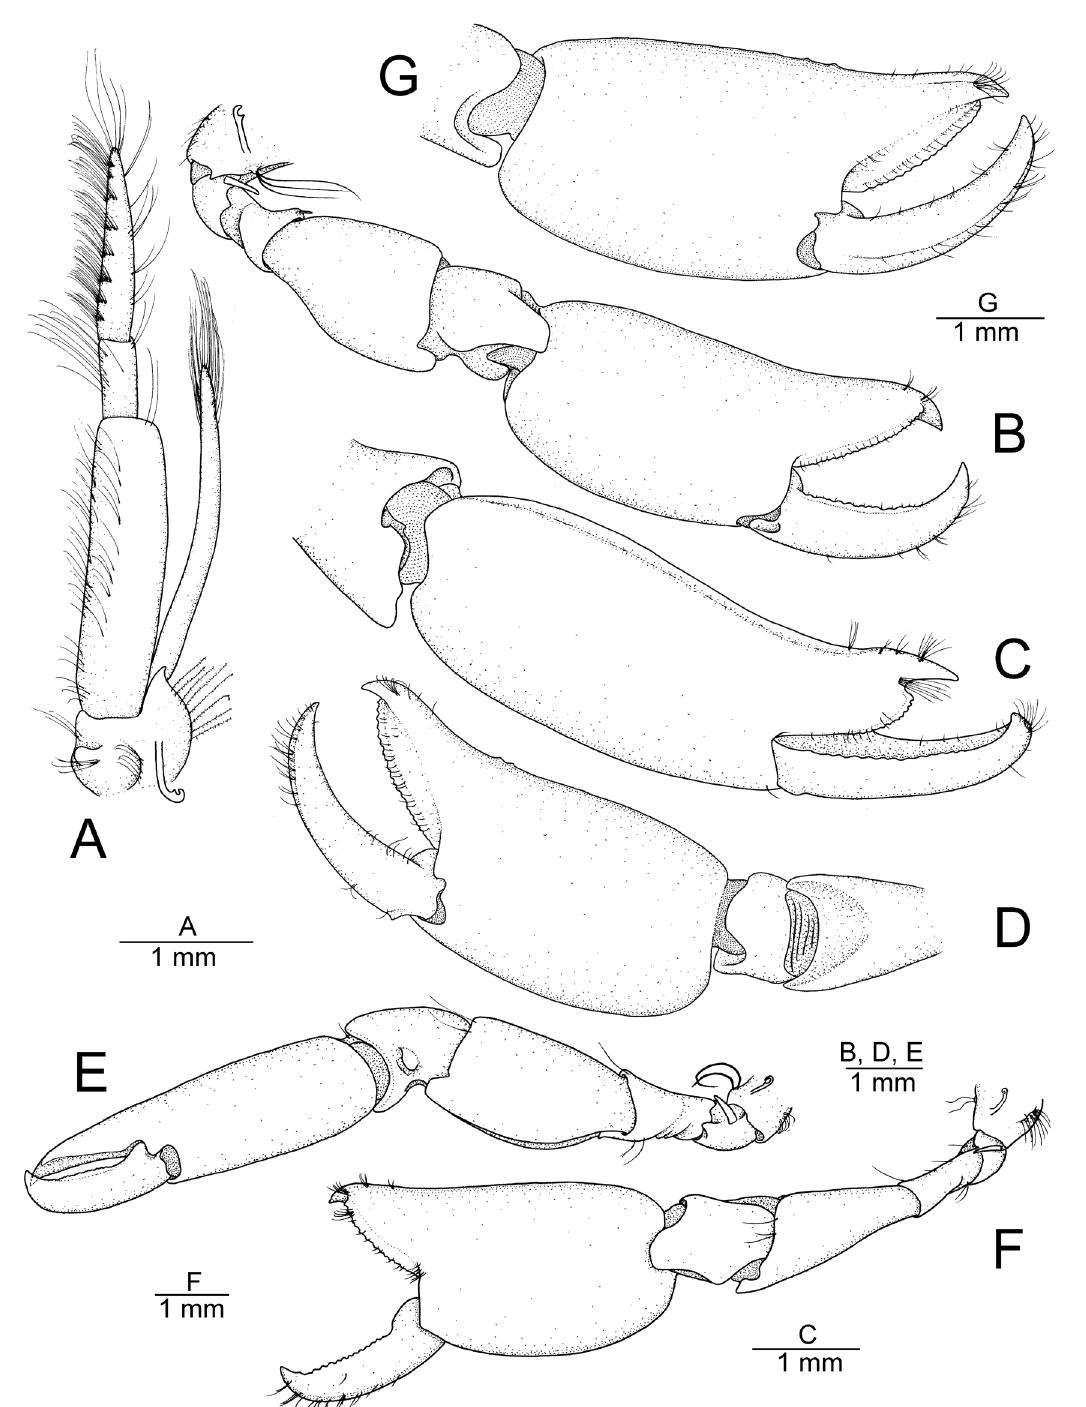
Fig. 2. Aretopsis sandybrucei sp. nov., holotype, ♂ (cl 5.31 mm) from Capel Bank, Coral Sea (MNHN-IU-2017-2924). A . Third maxilliped, lateral view. B . Right (major) cheliped, lateral view. C . Same, distal portion of carpus and chela, dorsolateral view. D . Same, distal portion of merus, carpus and chela, mesial view. E . Left (minor) cheliped, dorsolateral view. F . Same, chela fingers open, lateral view. G . Same, chela, mesial